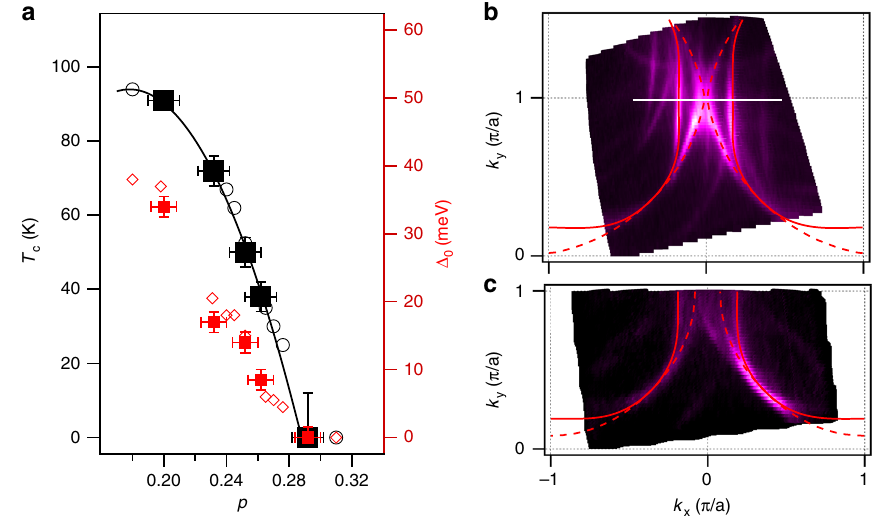
and Δ 0 c ¼ 72 K sample, corresponding to p ¼ 0 : 23. Maps in b and c were recorded at T = 12 K. c = k . The F F . The uncertainty in gap magnitude c